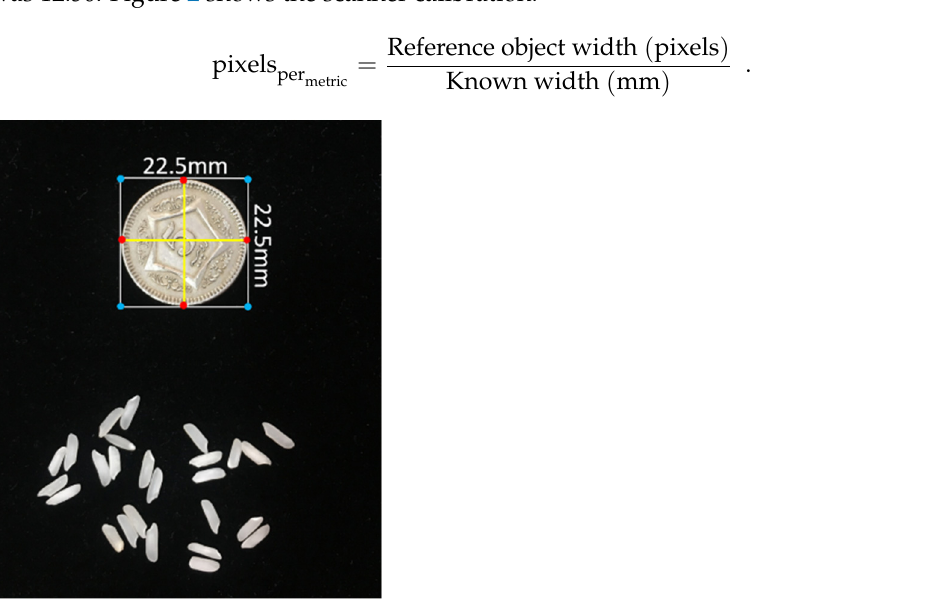
Figure 3. Visuals of ( a ) broken, ( b ) paddy, ( c ) yellow, ( d ) chalky, ( e ) damaged rice kernels. 4.2. Image Acquisition The quality testing process of the rice kernels was initiated by placing the rice sample on the flatbed scanner. The kernels were distributed in a single layer on the glass plate of the scanner and covered with a black sheet, such as paper or cloth, in order to capture an image in the reflected mode. Figure 4 shows an image of the rice sample acquired using a calibrated flatbed scanner.